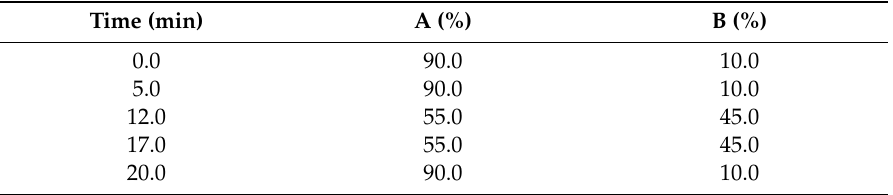
Table 1. HPLC mobile phase gradient program for apigenin